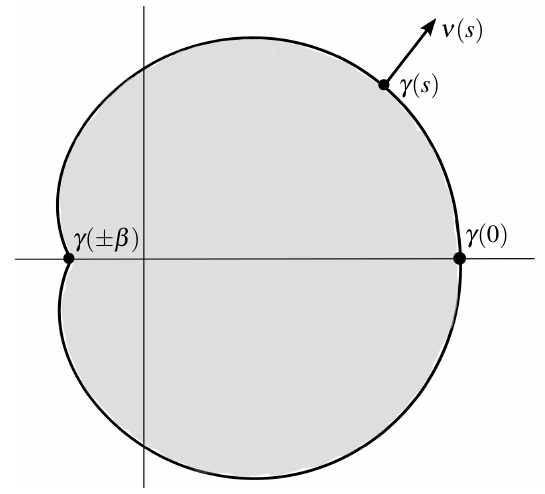
Figure 2: The generating curve γ and the outward unit normal vector at a point γ ( s